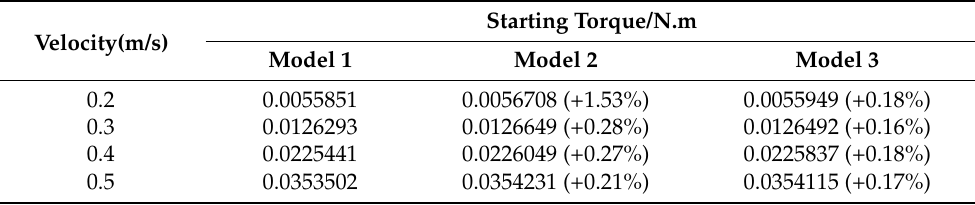
Table 5. The starting torques corresponding to the three models at different flow velocities.